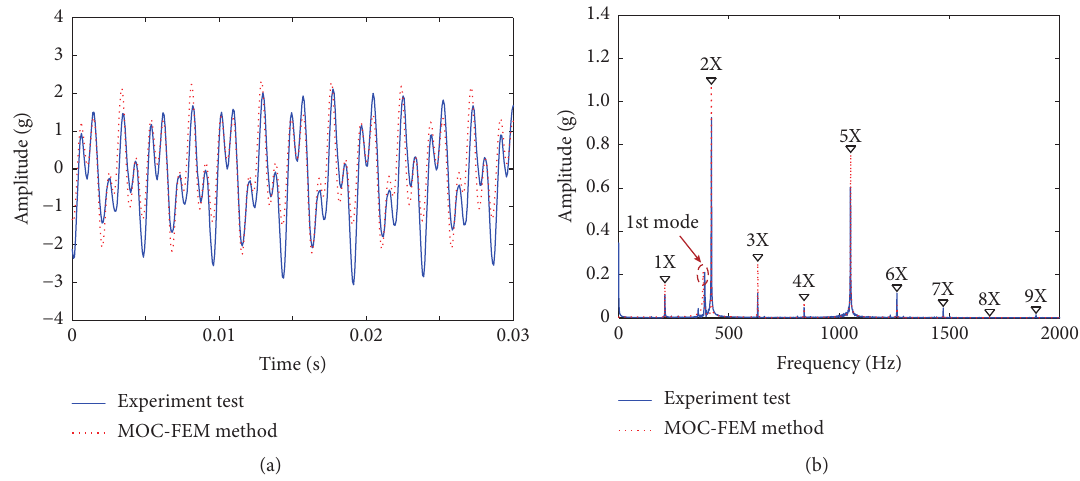
Figure 7: Pipeline vibration response at a pump speed of 1800r/min. (a) Vibration response for time domain and (b) pipeline frequency